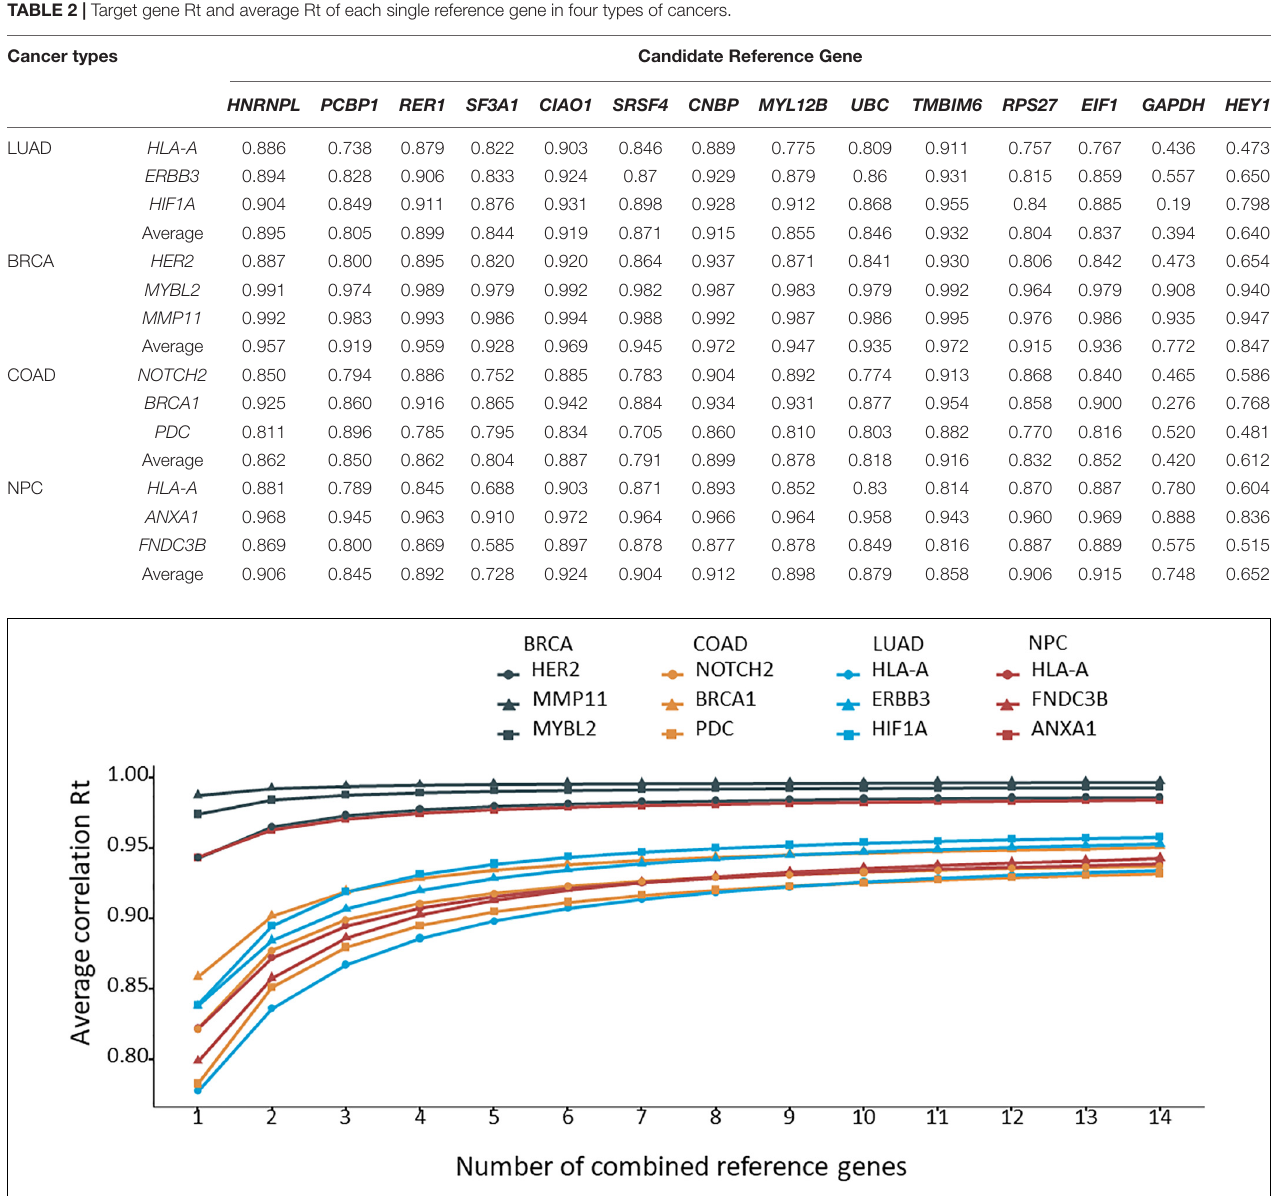
FIGURE 3 | The average correlation coefficient (Rt) for each number of combined reference genes. The target gene was normalized to the corresponding number of combined reference genes, and the average Rt was calculated and plotted.